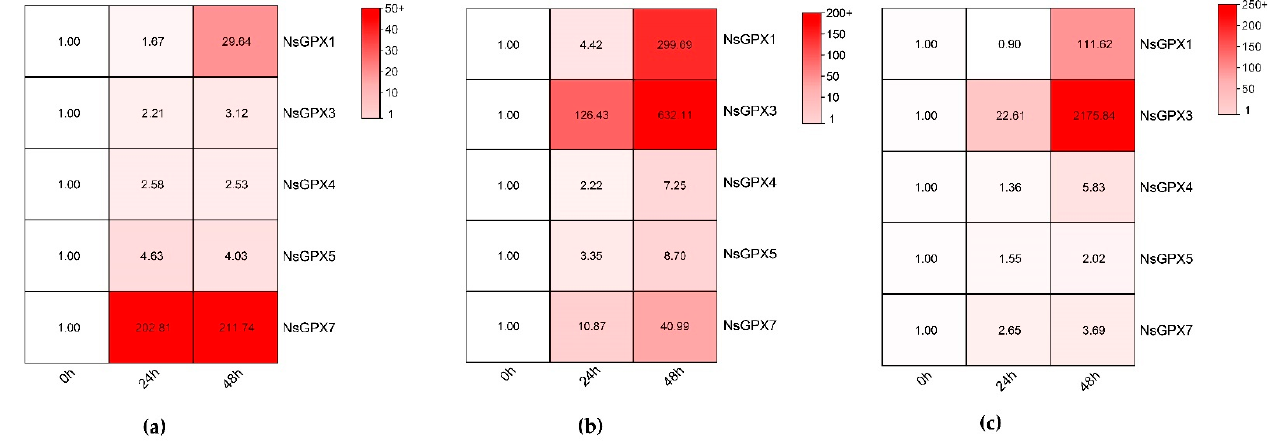
Figure 6. Expression profiles of NsGPX s under abiotic stress in root ( a ), stem ( b ), leave ( c ).